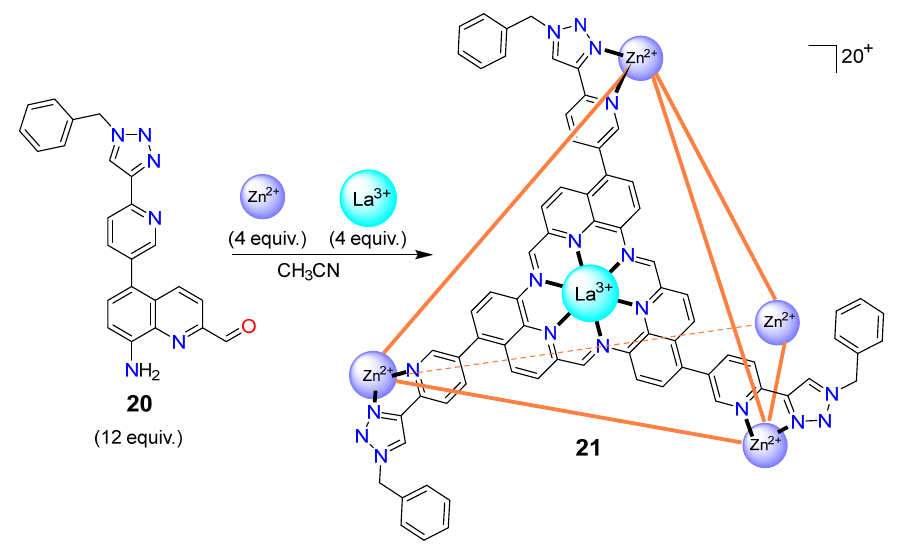
Figure 13. Two metal-ion-directed self-assembly of tetrahedron 21 from 2-formal-8-aminoquinoline ( 20 ) involving in situ metalloligand assembly. For clarity, only one face of 21 is shown [122].